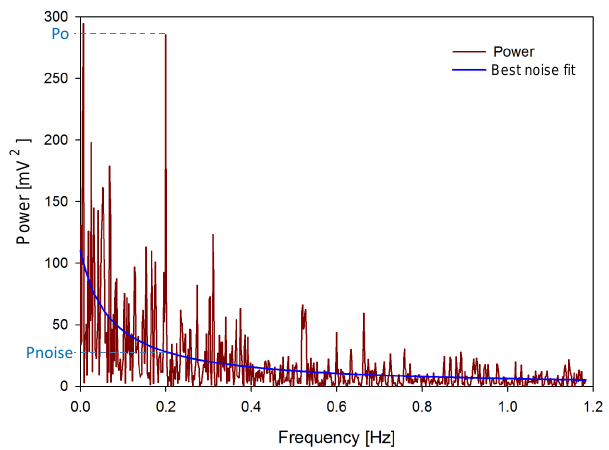
Figure 6. Sorted amplitude distribution for the alpha-trimmed- mean